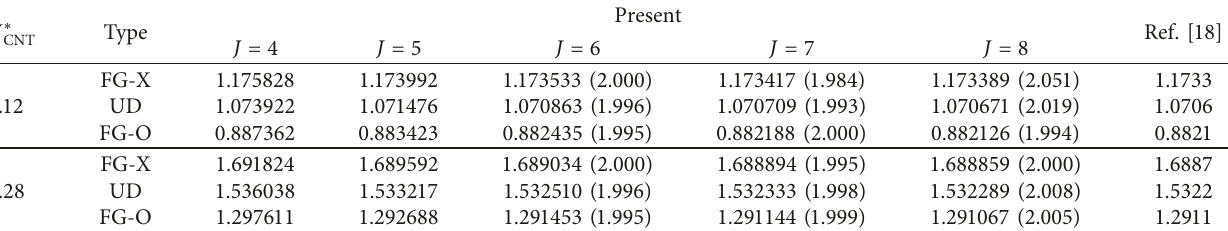
T ABLE 2: Convergence of linear fundamental frequency parameters Ω K